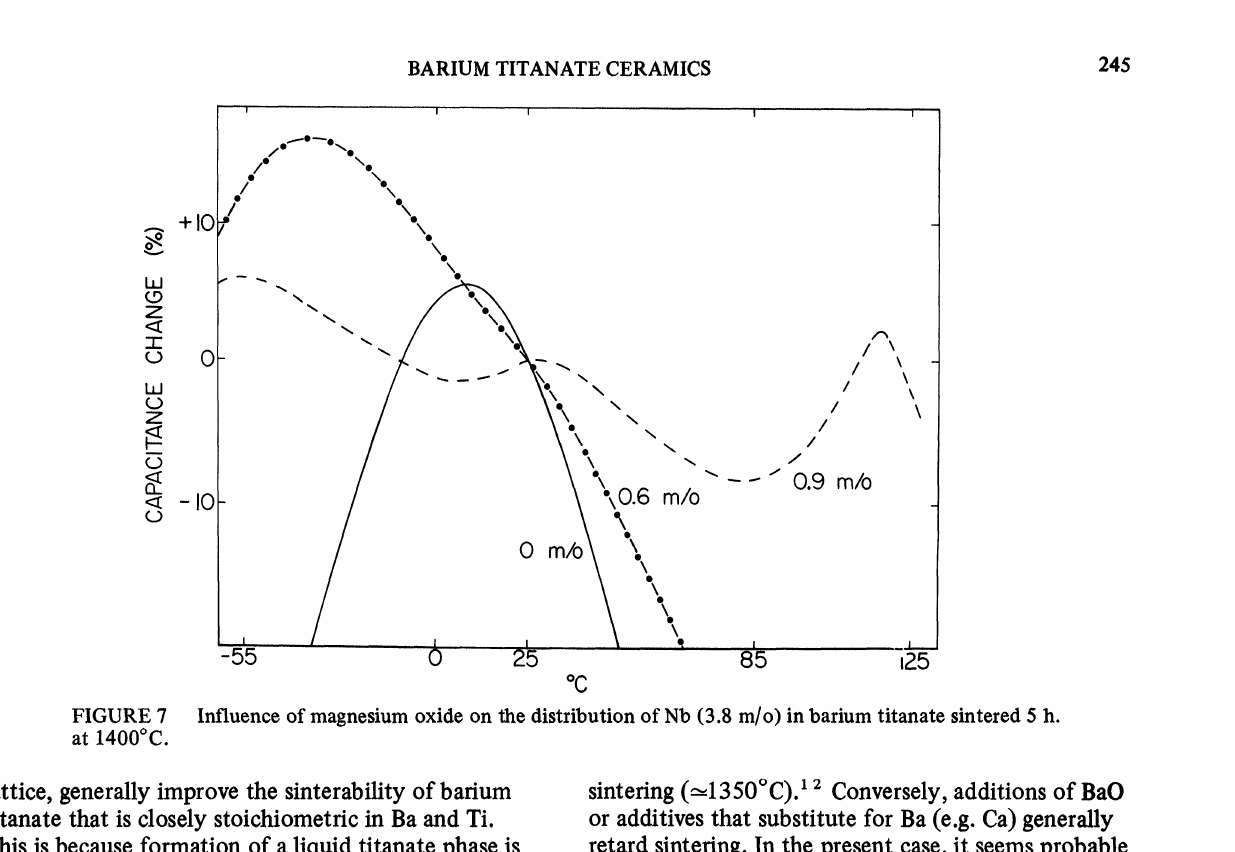
FIGURE 7 at 1400 C.